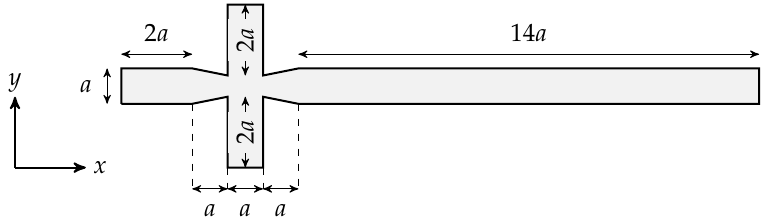
Figure 2. Schematic illustration of the two-dimensional channel used in this study ( a = 50 µ m).